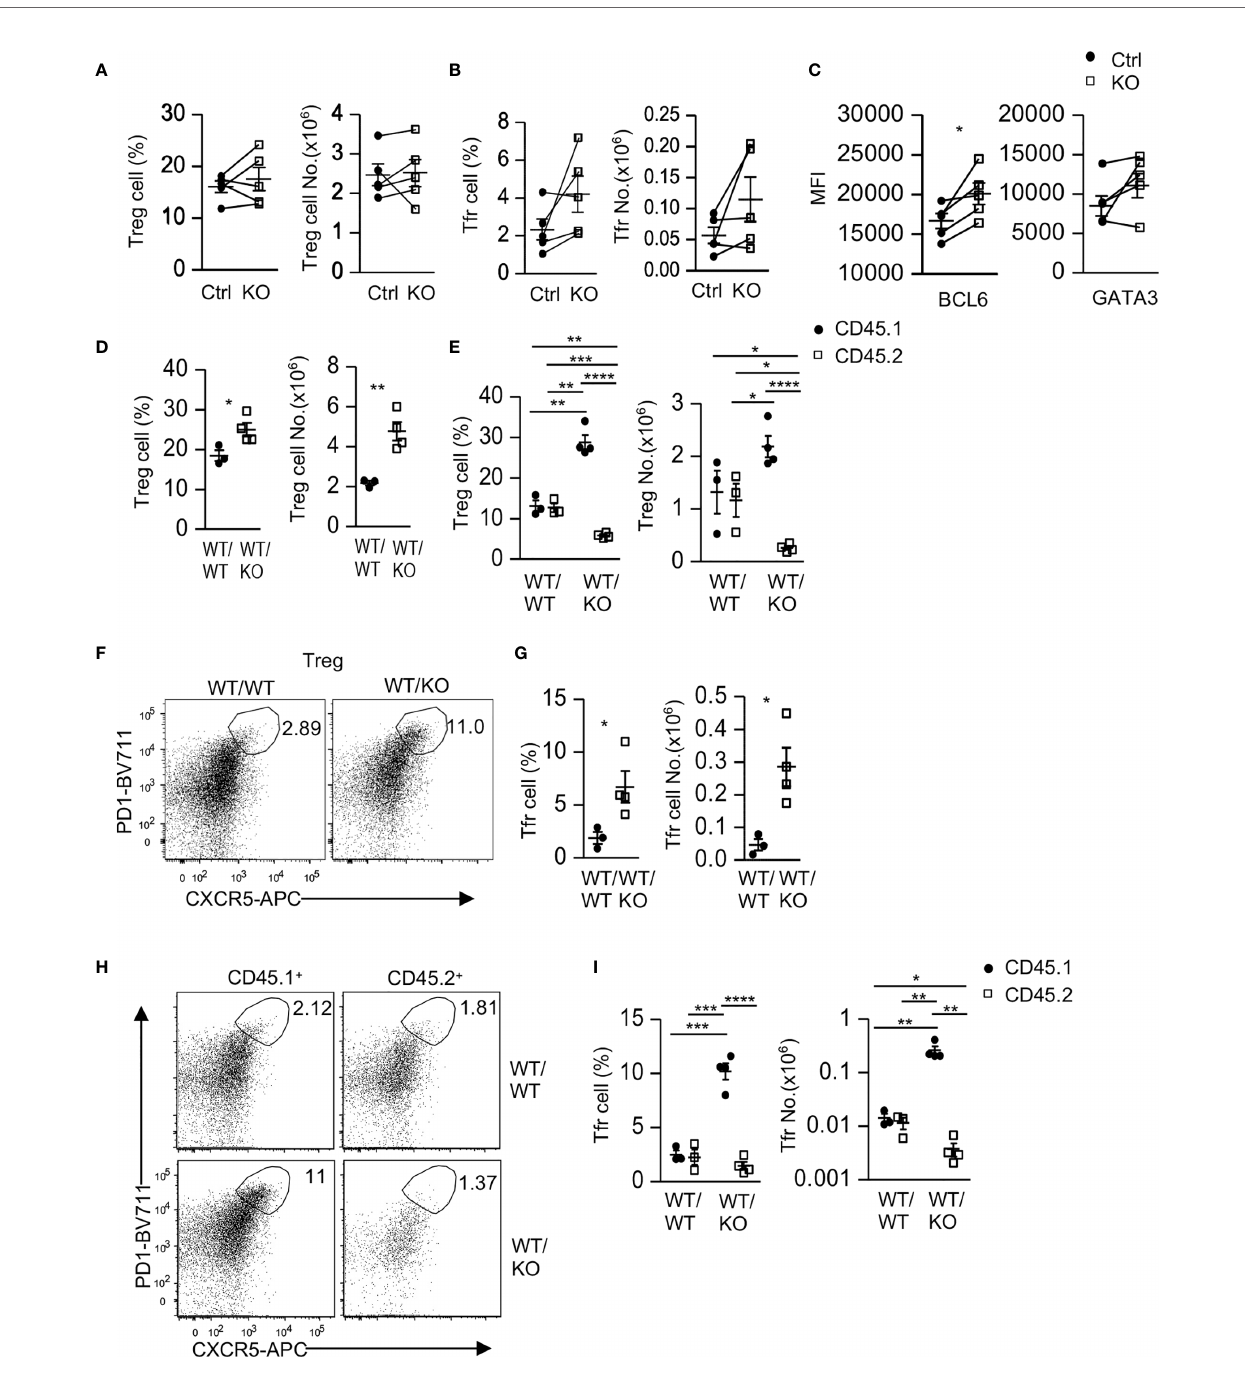
FIGURE 5 | Intrinsic and extrinsic regulation of Tfr cells by Tsc1. (A – C) Splenocytes from 8 – 10 weeks old Tsc1 f/f Cd4Cre and WT control mice were analyzed. (A) Scatterplots represent mean ± SEM of Treg percentages and numbers. (B) Scatterplots represent mean ± SEM of Tfr cell percentages and numbers. (C) Scatterplots represent mean ± SEM of Bcl6 and Gata3 MFI in Tfr cells. (D – I) Analysis of splenocytes in CD45.1 + WT/CD45.2 + WT (WT/WT) and CD45.1 + WT/CD45.2 + Tsc1-T-KO (WT/KO) mixed BM mice described in Figure 2 . (D) Scatterplots represent mean ± SEM of Treg percentages and numbers in WT/WT and WT/KO spleens. (E) Scatterplots represent mean ± SEM of CD45.1 + and CD45.2 + Treg percentages and numbers in WT/WT and WT/KO spleens. (F) Representative dot-plots of CXCR5 and PD1 staining in live gated splenic CD4 + TCR b + Foxp3 + Tregs in WT/WT and WT/KO mice. (G) Scatterplots represent mean ± SEM of Tfr cell percentages and numbers in WT/WT and WT/KO spleens. (H) Representative dot-plots of CXCR5 and PD1 staining in live gated CD45.1 + or CD45.2 + splenic Tregs in WT/WT and WT/KO mice. (I) Scatterplots represent mean ± SEM of CD45.1 + and CD45.2 + Tfr cell percentages and numbers in WT/WT and WT/KO spleens. * p < 0.05; ** p < 0.01, *** p < 0.001, **** p < 0.0001 determined by a two-tailed pairwise (A – C) and unpaired (D, E, G, I) Student t